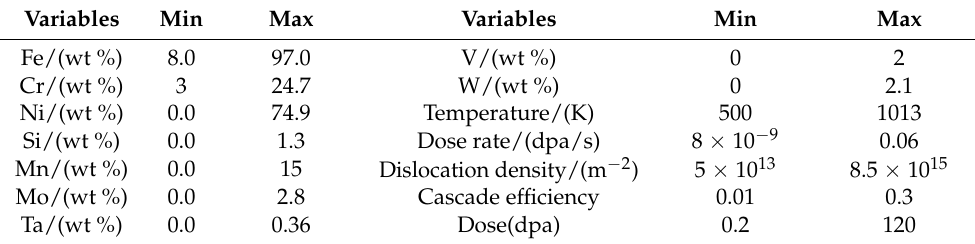
Table 1. The range of numerical variables in the